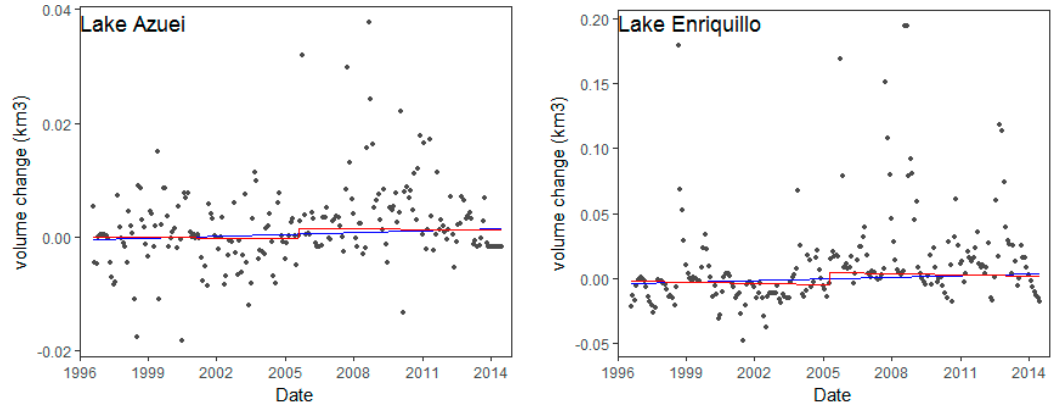
Figure 11. The demonstration of both tend and step (CP) fitted the time series for Lake Azuei and Lake Enriquillo [time series values (grey colored points), monotonic trend (blue line), trend lines and step change (CP) (red line)].